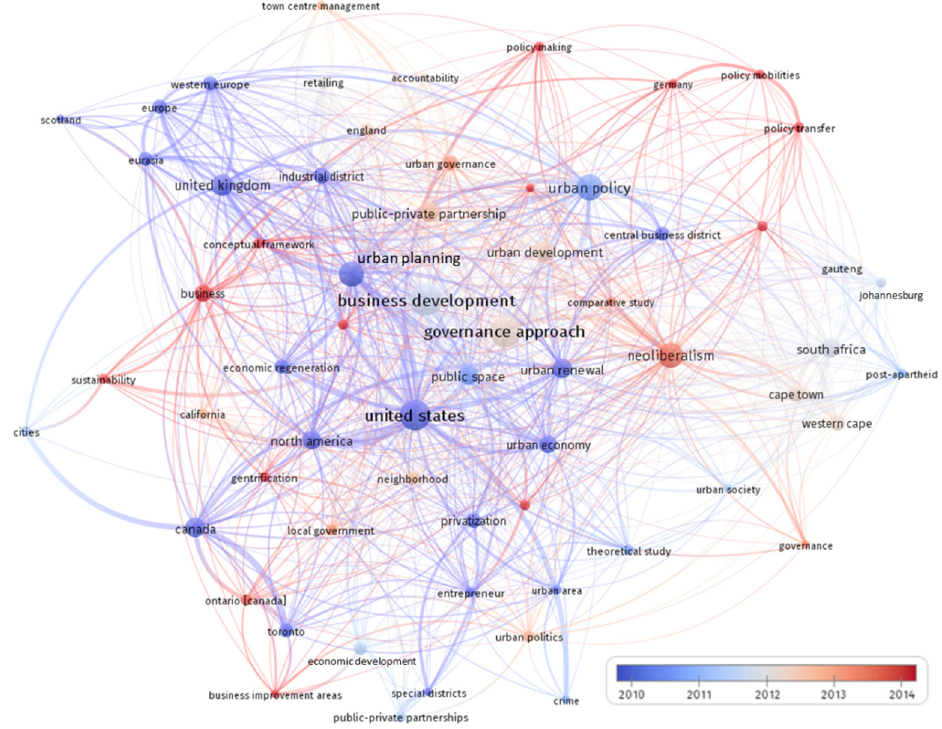
Figure 6. Longitudinal Conceptual and Thematic Structure of Academic Knowledge on BIDs (All keywords with at least 5 co-occurrences were included. “Business Improvement Districts” were removed).